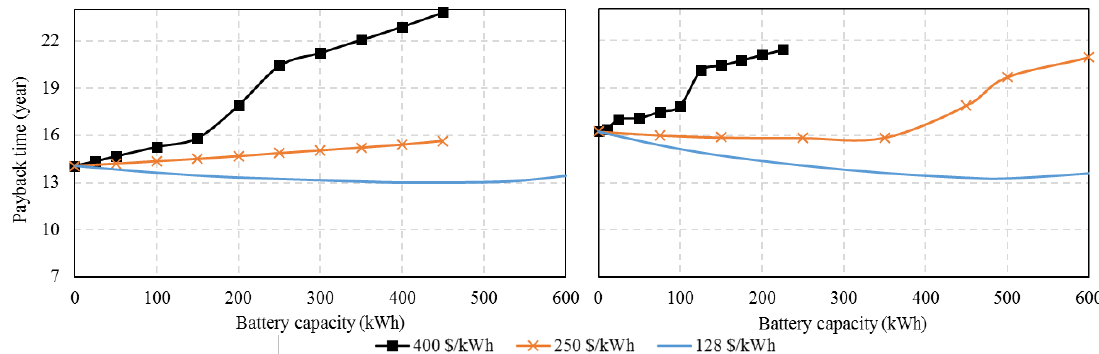
Figure 11. The effect of the battery capacity on the payback time of the PV system for feed-in tariff = 6.7 ₵ /kWh ( left ), and 3.35 ₵ /kWh ( right ). Annual saving target 75%.